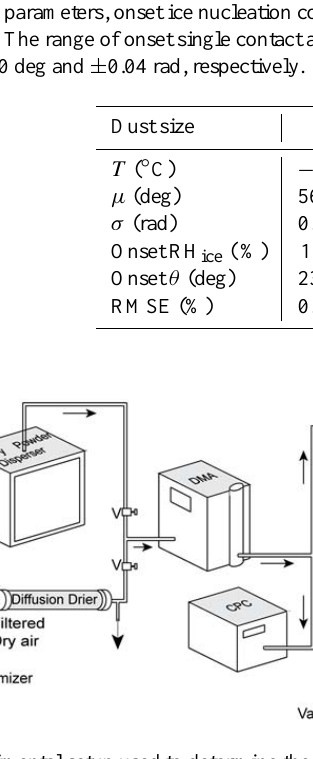
Fig. 1. Experimental setup used to determine the IN fraction of dust particles. The ATD particles are dry dispersed size selected and in- vestigated for their ice nucleation efficiency. The atomizer set up is used to validate the temperature and RH ice conditions within the CIC (data not shown here). The polydisperse particles of ammo- nium sulfate were generated in the atomizer, and passed through the drier to remove any water droplets and water residing on the ammo- nium sulfate particles. The sample flow is forwarded to the DMA and consequently to CIC and CPC. The remainder of the flow went to the exhaust. The valve (V) was used to switch between these two types of experiments. The mass flow controller (MFC) was used to regulate the CIC flows.